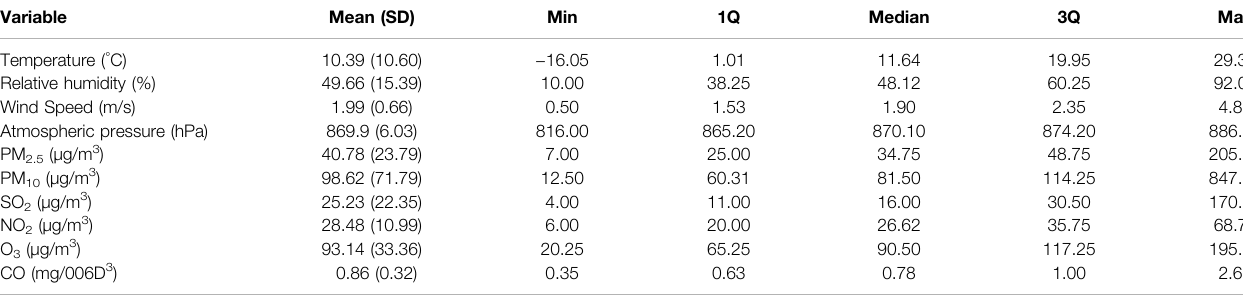
TABLE 1 | Descriptive analysis of environmental factors in Ningxia, 2015 – 2019. Variable